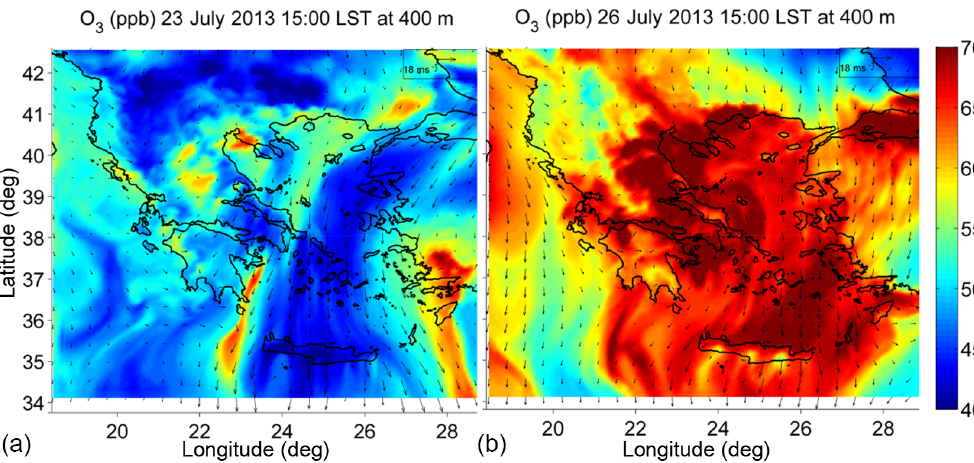
Figure 5. Spatial distribution of O 3 concentration (ppb) and wind speed (ms − 1 ; shown with arrows) at 400ma.s.l. over the extended area of Greece as simulated by WRF-Chem at 15:00 LST for 23 July (EF – left panel) and 26 July (MSF – right panel).